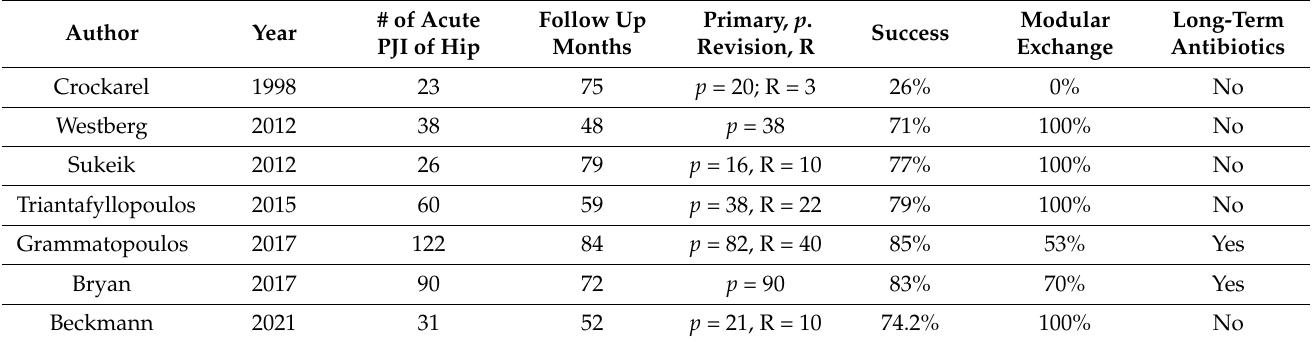
Table 5. Studies showing infection elimination/control with additional DAIR and I and